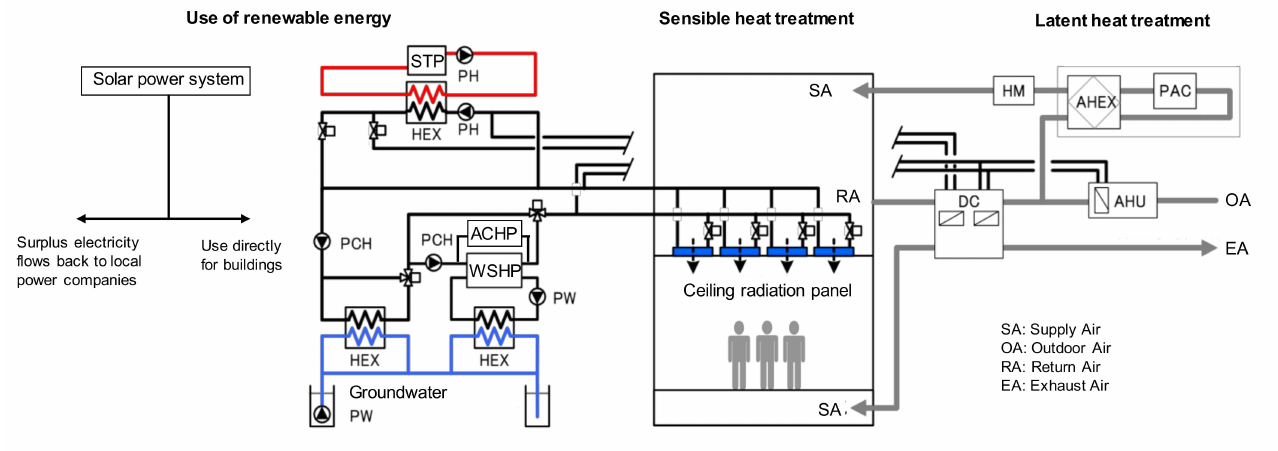
Figure 3. Diagram of air conditioning system using renewable energy.